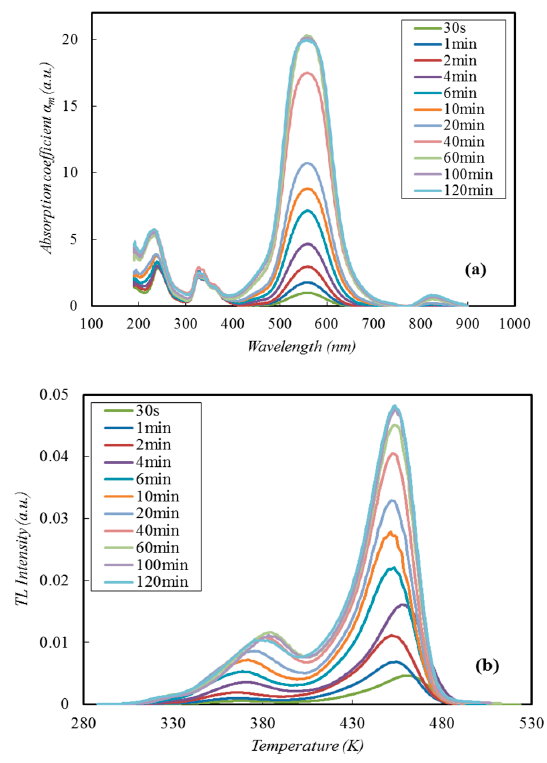
Figure 6. Variations of ( a ) absorption spectrum and ( b ) TL glow curve of X-ray irradiated KCl:Eu 2+ (0.04 mol%) single crystals with the irradiation time.